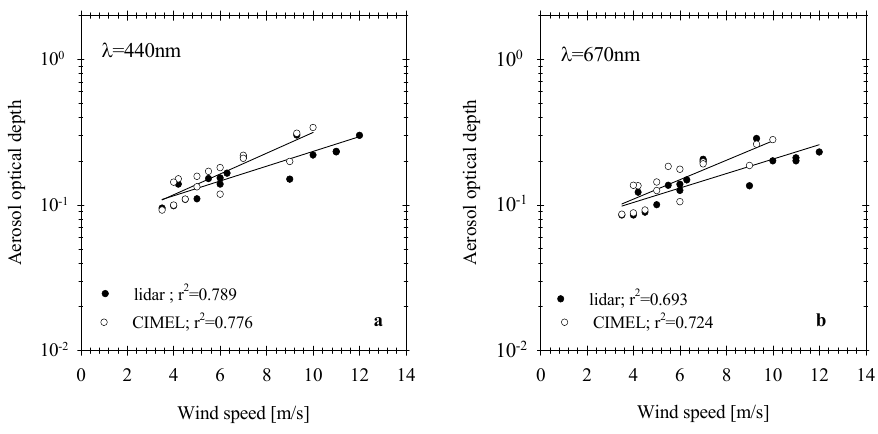
Figure 5. Comparison of AOD values measured simultaneously in Duck, NC using the FLS-12 lidar and CIMEL CE-318-1 for onshore winds at 440 nm (a) and 670 nm (b).